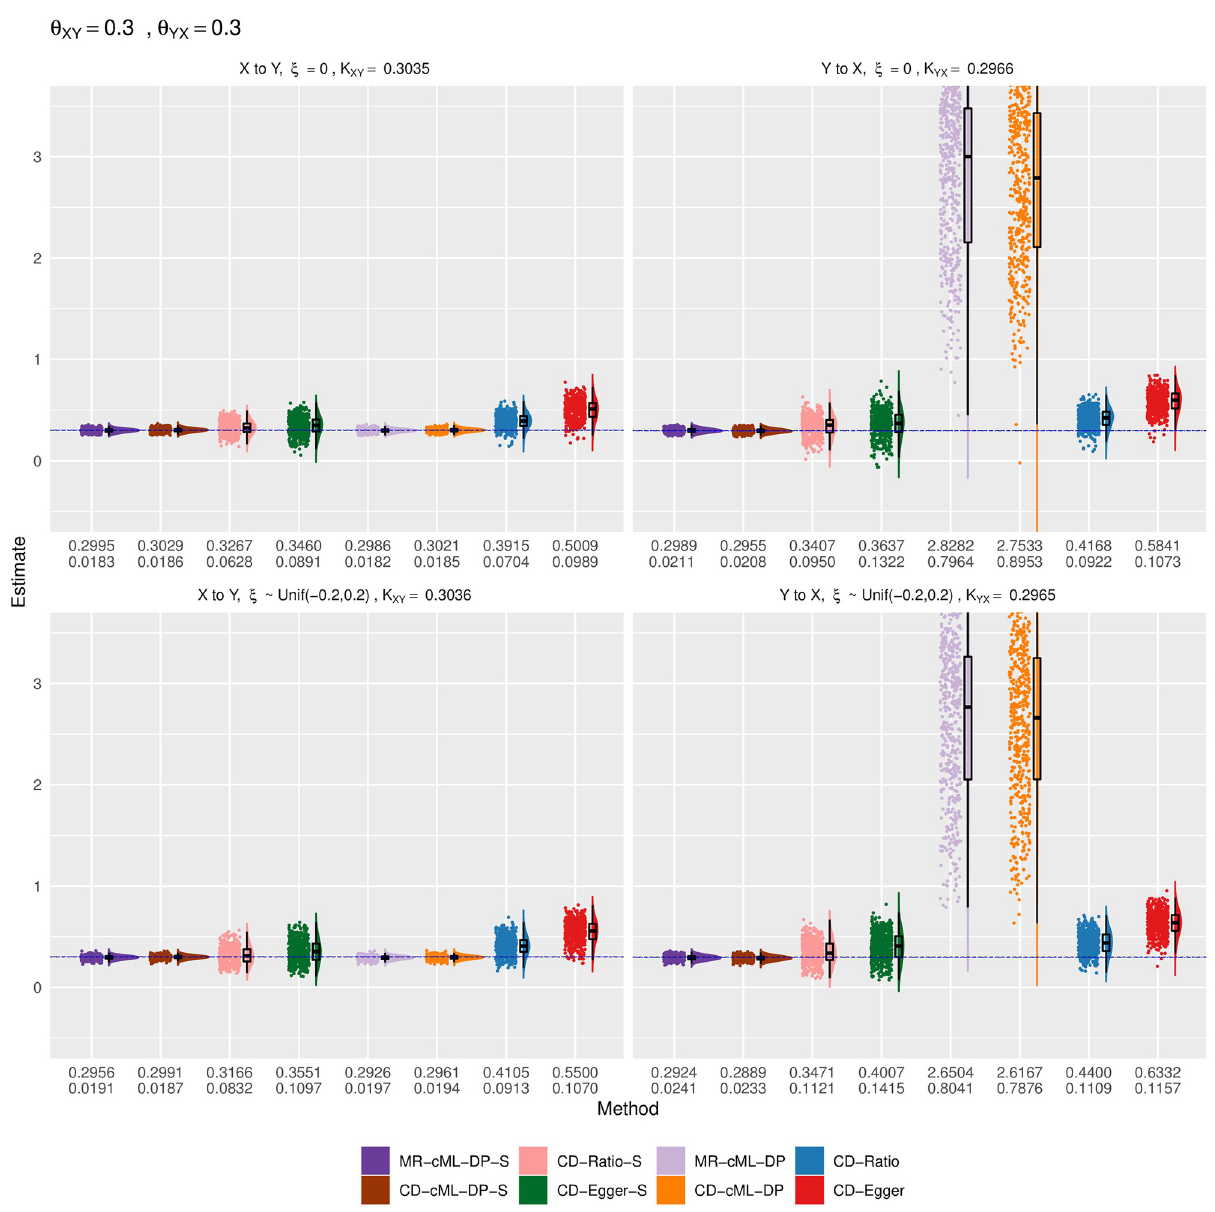
Fig 9. Empirical distributions of the estimates of the correlation ratio K for CD methods and the causal effect θ for MR method with both X and Y continuous, true θ XY = 0.3 and θ YX = 0.3. The top and bottom panels show the results for ξ = 0 (i.e. no correlated pleiotropy) and ξ from a uniform distribution (i.e. with correlated pleiotropy, implying InSIDE violated), respectively. The left panels show the estimates for the causal direction of X ! Y , while the right ones show that for Y ! X . The horizontal dashed lines are for the true values of K (in blue) and θ (in black). The two rows of the numbers under each panel give the sample mean and standard deviation of the estimates from each